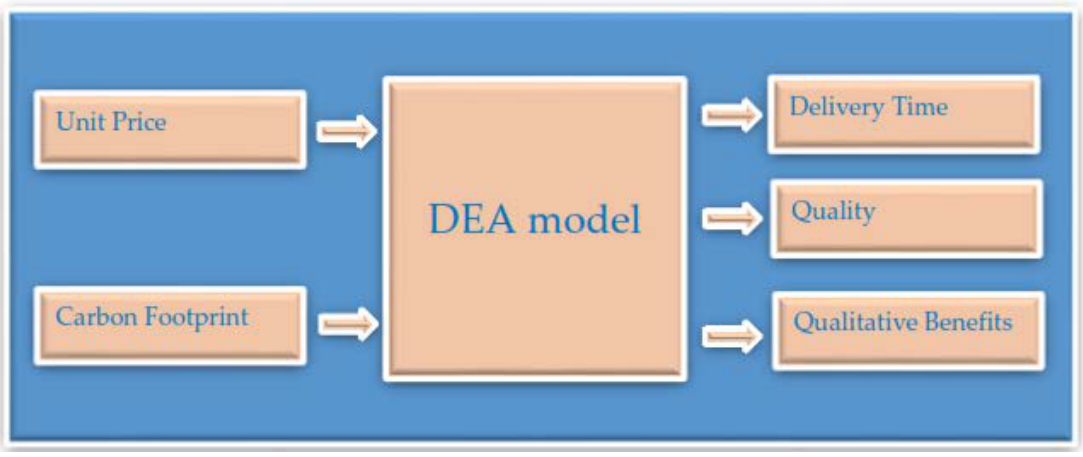
Figure 4. A Graphic of the green data envelopment analysis (GDEA) model.